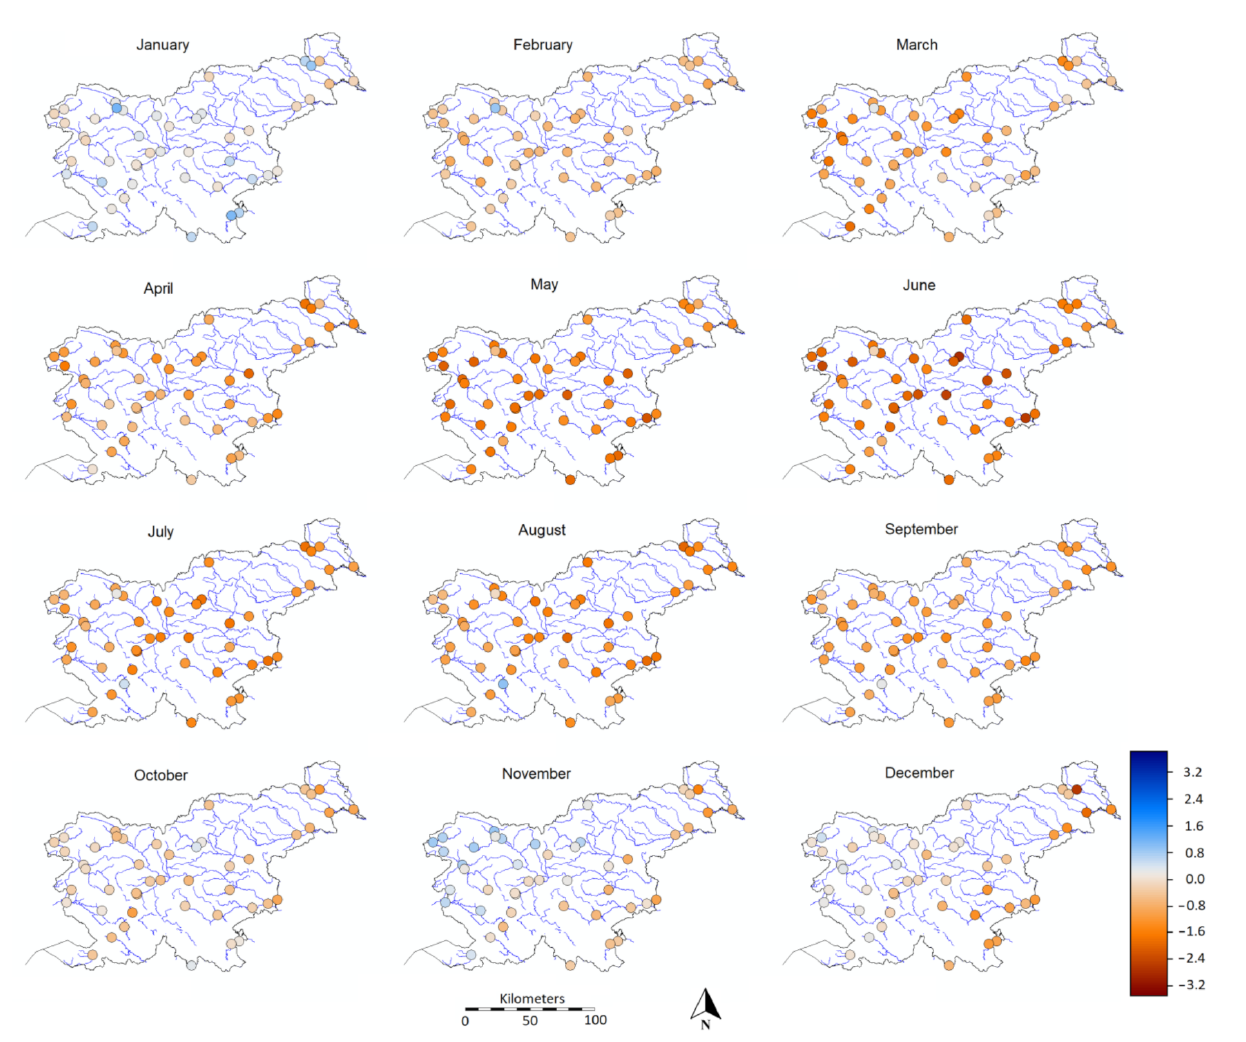
Figure 4. Spatial presentation of SSI-1 values for a dry year 2003.